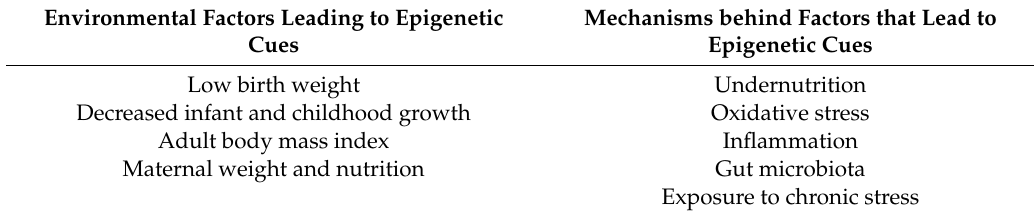
Table 2. Environmental factors and mechanisms that lead to epigenetic